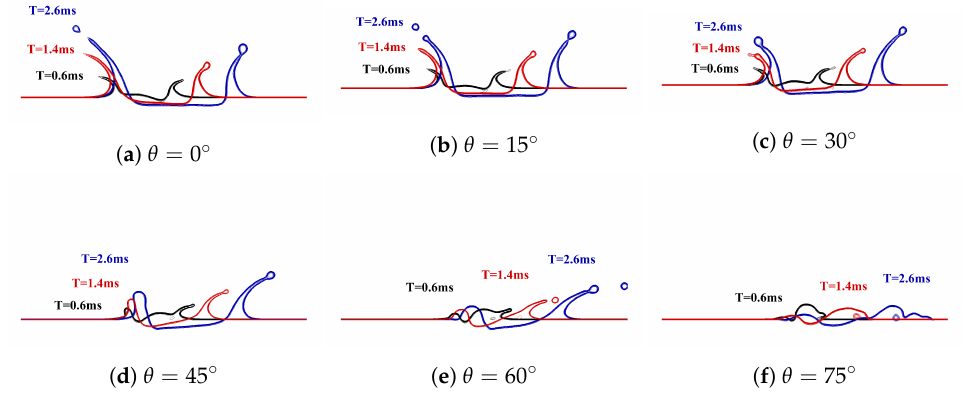
Figure 5. Interface of a drop impingement onto a dynamic film at different impact angles.